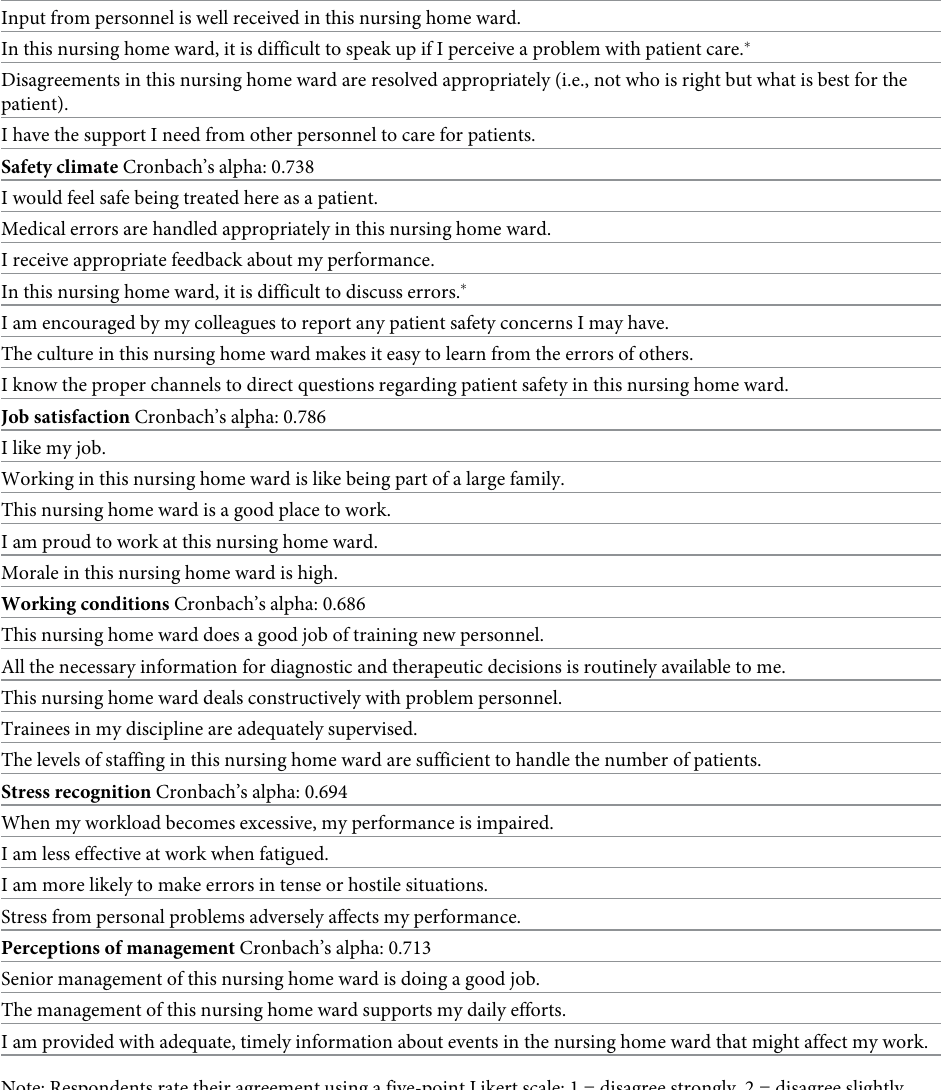
Table 1. The six patient safety climate factors and corresponding items in the validated Norwegian translation of the Safety Attitudes Questionnaire–Ambulatory Version (SAQ-A) for nursing homes. Teamwork climate Cronbach’s alpha: